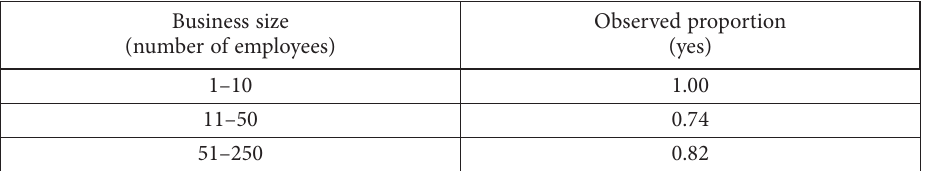
Table 2. Pivot table: alternative hypothesis (H1) from the perspective of business size (source: created by